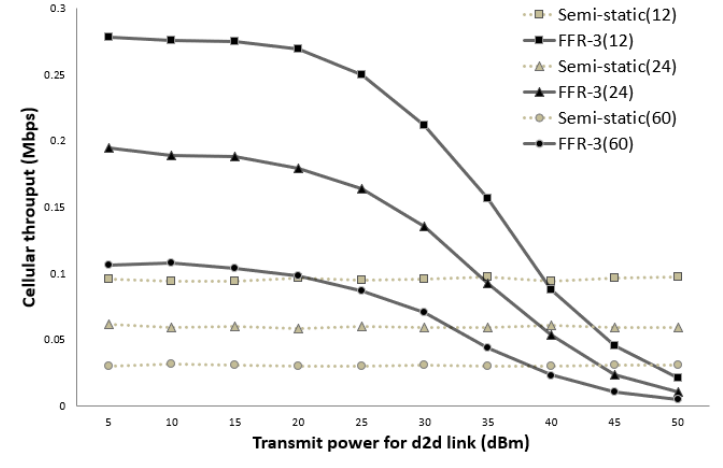
Figure 15. Cellular link throughput versus D2D transmit power (cellular Tx power = 40